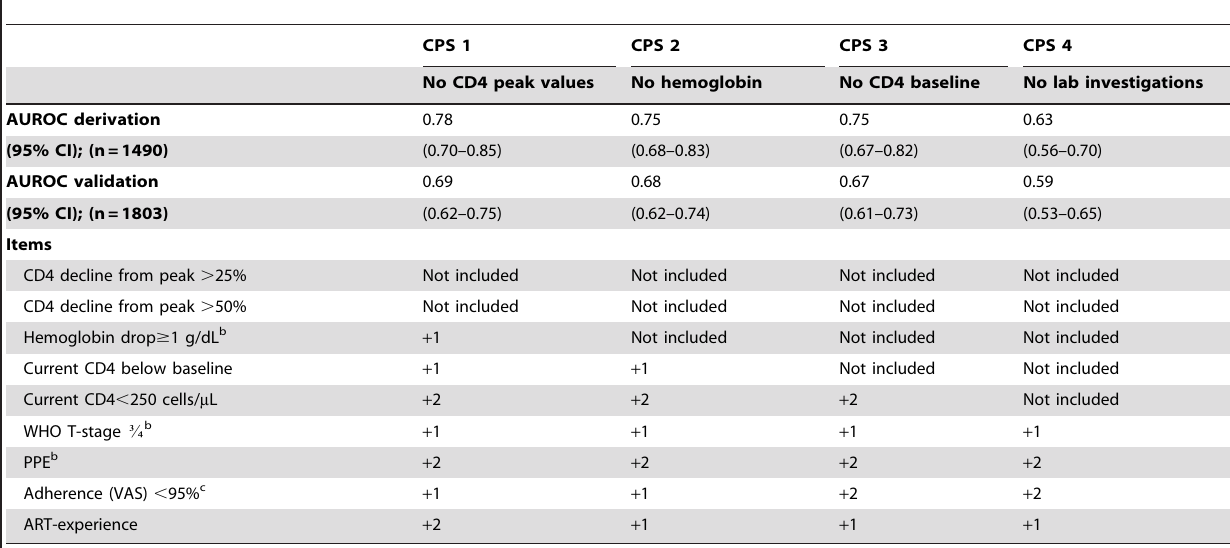
Table 2. Content and diagnostic performance of the simplified clinical prediction scores to identify virological failure a